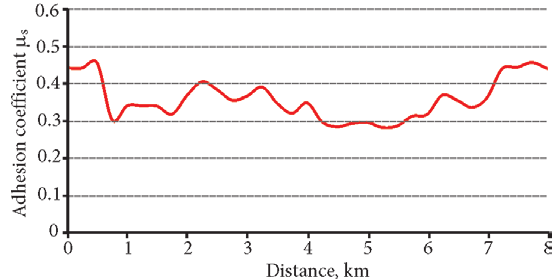
fig. 7. Changeability of the sliding adhesion coefficient in the measurement points shown on the map in Fig. 6. The mean value of the coefficient equals 0.36